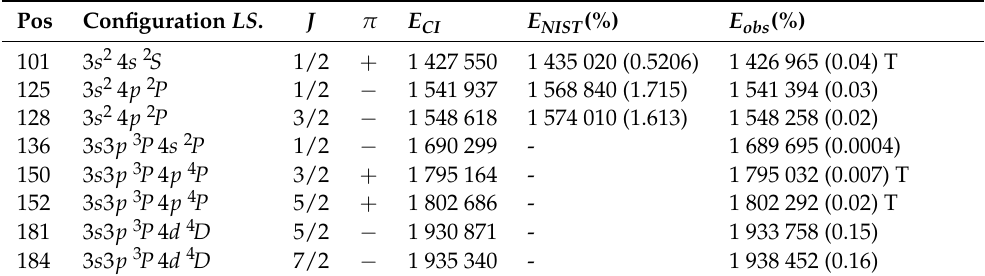
Table 8. Energies (in cm − 1 ) for a few selected n = 4 levels in Fe XIV. E CI are energies from [167], E NIST from NIST [168] and E obs from [169], along with three new tentative (T) values. Values in parentheses are percentage differences with respect to E CI . Pos Configuration LS .